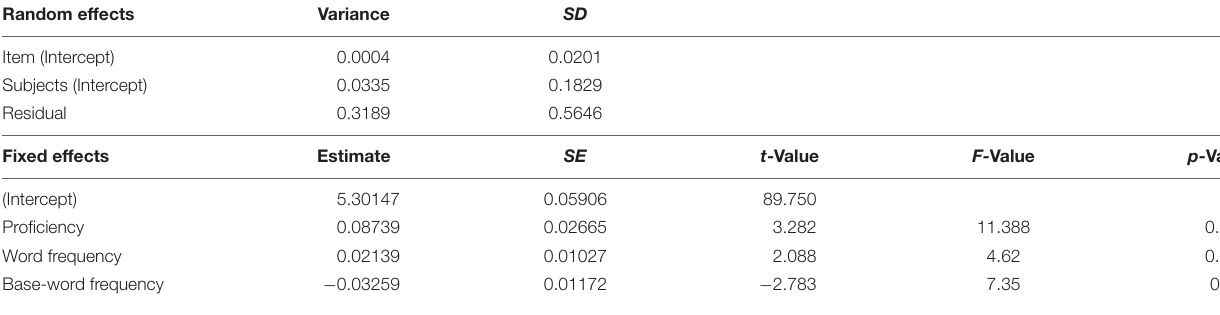
TABLE 3 | Words derived from noun base: mixed-effects on first-fixation duration. Random